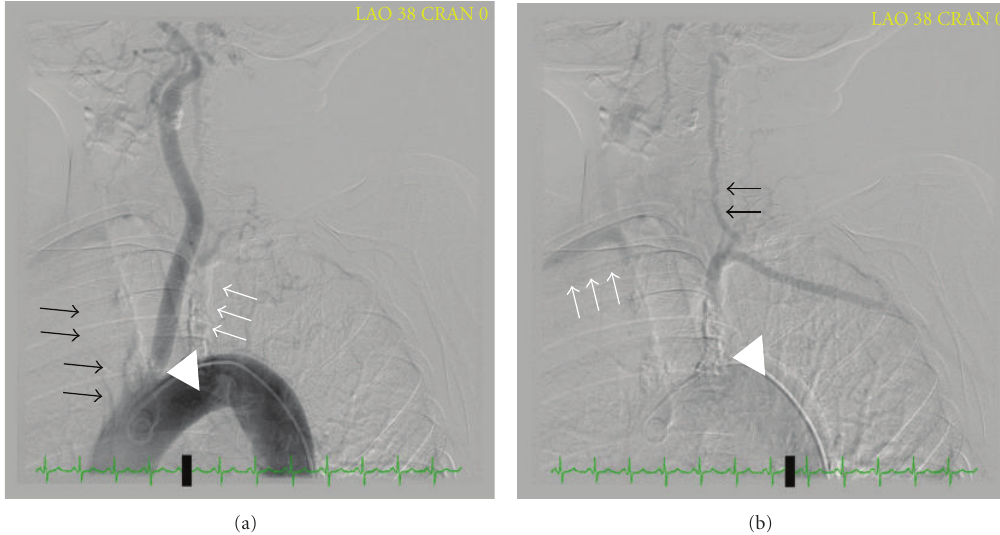
Figure 4: Arch aortography revealing a Type II arch. (a) Totally occluded innominate artery (black arrows) and left subclavian artery (white arrows). Note the left common carotid artery with 50% ostial stenosis (white arrow head). (b) Left subclavian artery (white arrow head) is heavily calcified and totally occluded. It is filled via retrograde flow from left vertebral artery (black arrows). Right subclavian artery (white arrows) is filled via retrograde right vertebral and carotid arteries (not seen well on this